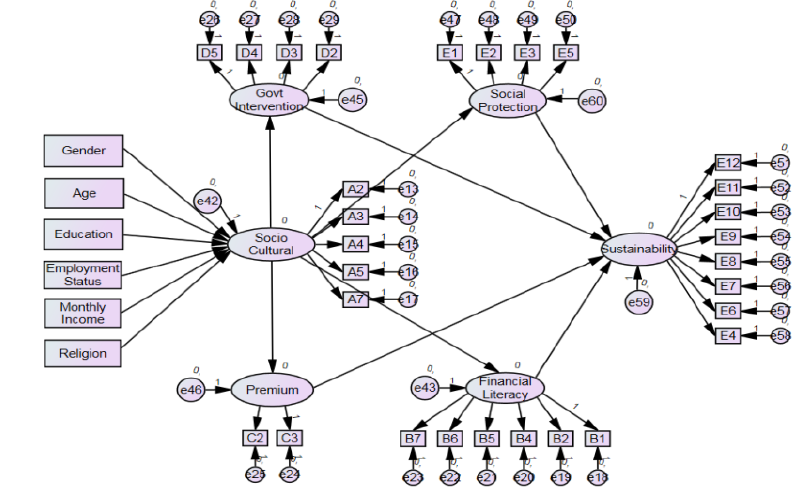
Figure 1: Hypothesized Model with specific